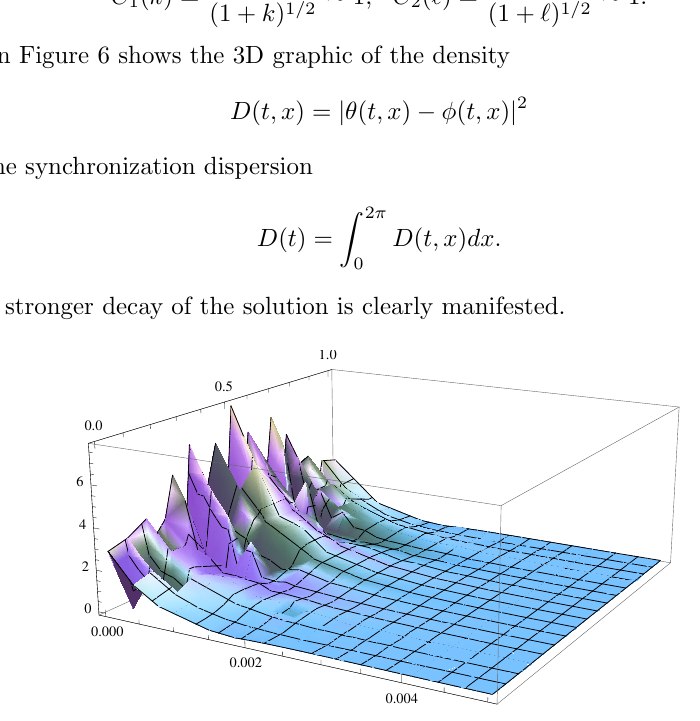
Figure 6. Graphics of the density D ( t,x ) of the synchronization dispersion D ( t ). We have synchronization combined with very strong dissipation for A = − 1 .